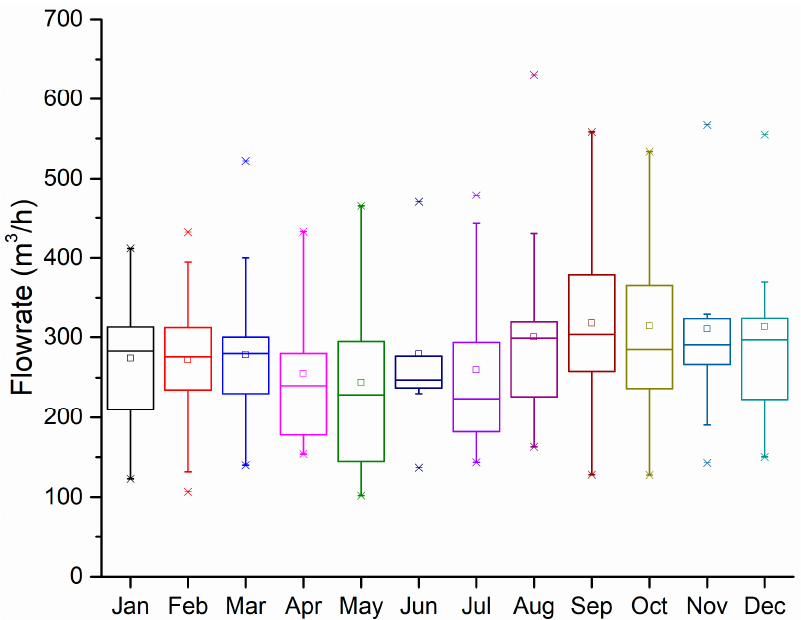
Figure 2. Average monthly rendering RCWW flow from the plant in 2017.